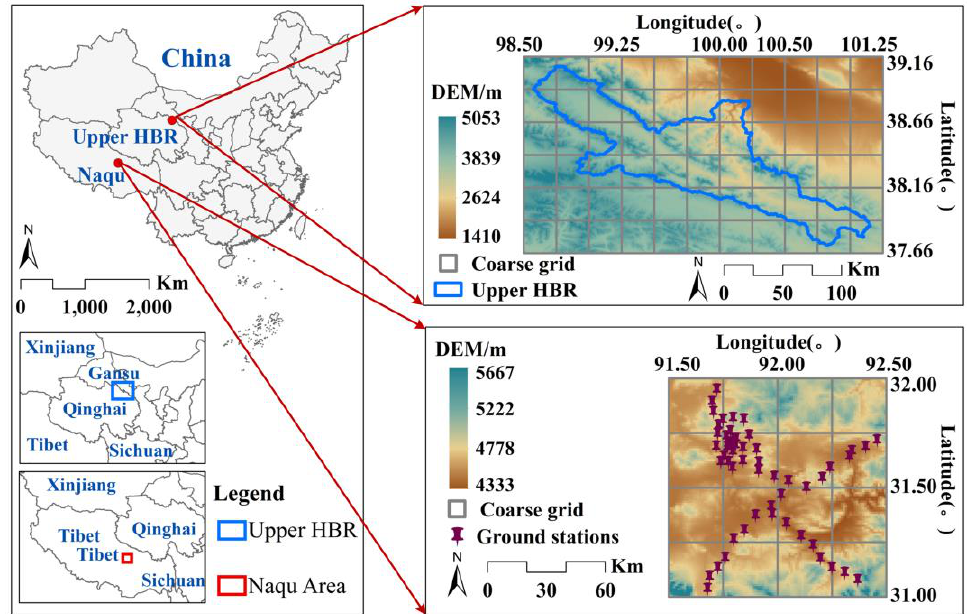
Figure 1. Locations and elevations of the two experimental regions: the upper HBR area and the Naqu area. The spatial distribution of the ground stations in the Naqu area and the arrangements of the coarse grid pixels for both areas are also shown.